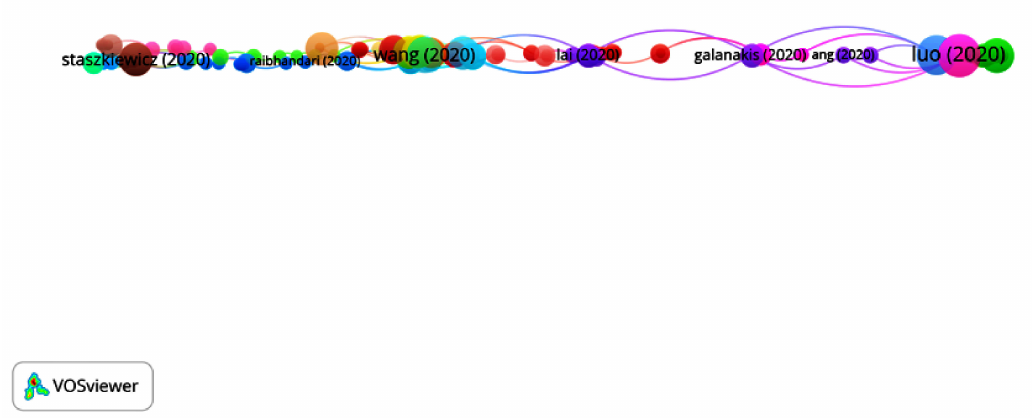
Figure 14. Citation network for Group